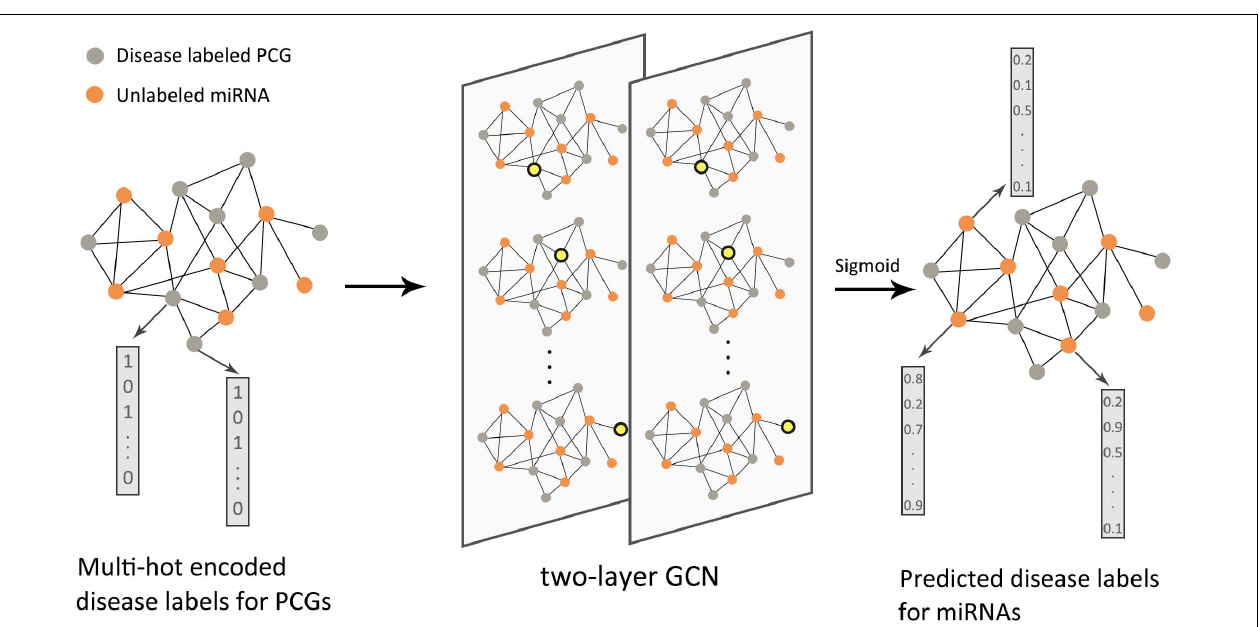
occurrence and development of diseases (Xuan et al., 2019a; Li